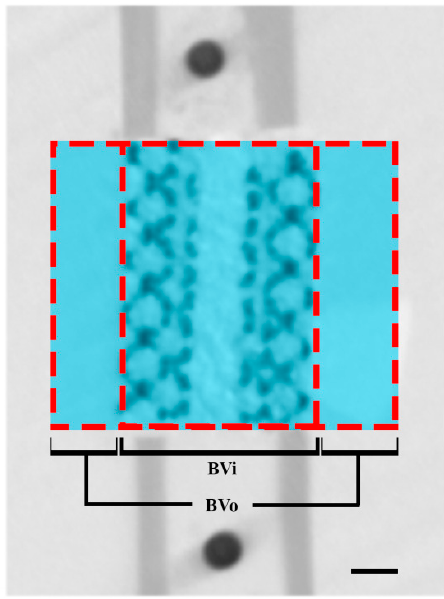
Figure 1. Region of interest on micro-CT scanning. Bone volume inside (BVi) and bone volume outside (BVo) are defined as bone formed inside and outside the porous space and the medullary canal of the titanium implants. Scale bar indicates 1 μ m.